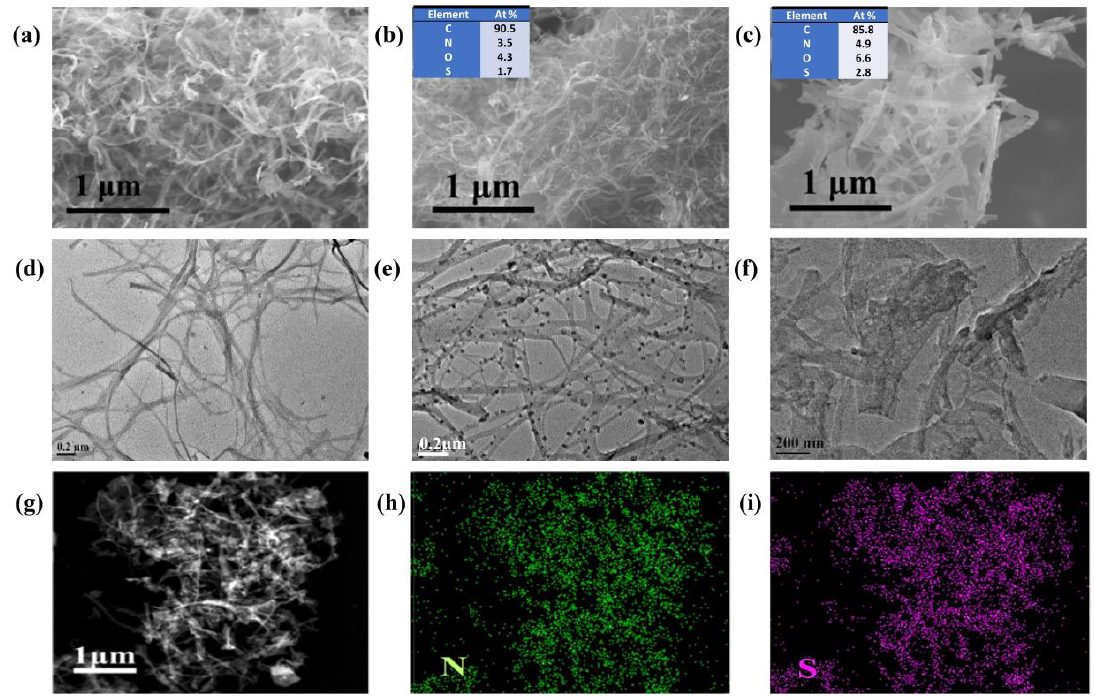
Figure 4. SEM and TEM images of the ( a , d ) C-BC; ( b , e ) C-BC/MB and ( c , f ) N/S-CNF; and the element maps ( g – i ) of N,S-CNF. The insets in ( a , b ) are EDS data.